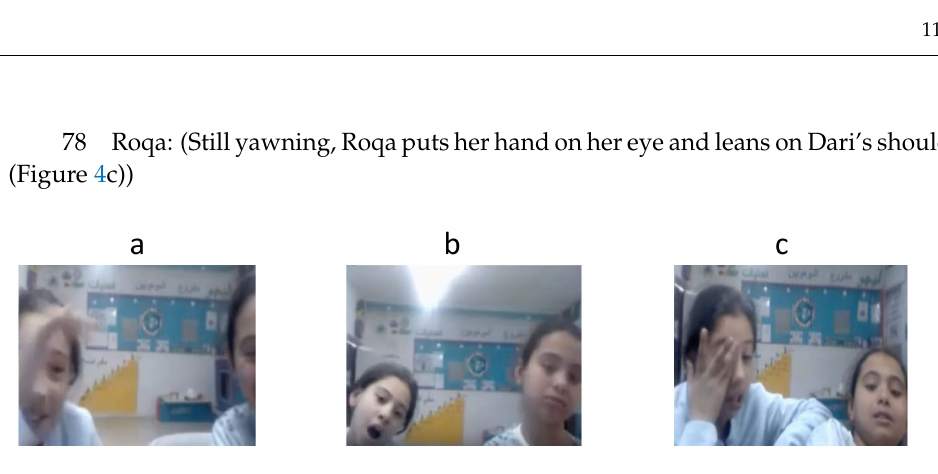
Figure 4. ( a ) Roqa (left) puts her hand in front of her head; ( b ) Roqa, bored, holds the mouse and yawns; ( c ) still yawning, Roqa puts her hand on her eye and leans on Dari’s